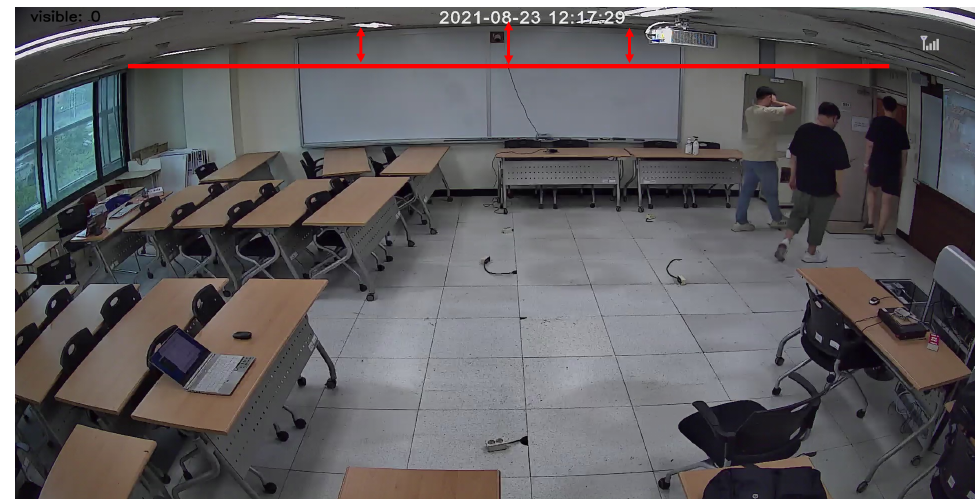
Figure 2. Barrel distortion commonly observed in commercial